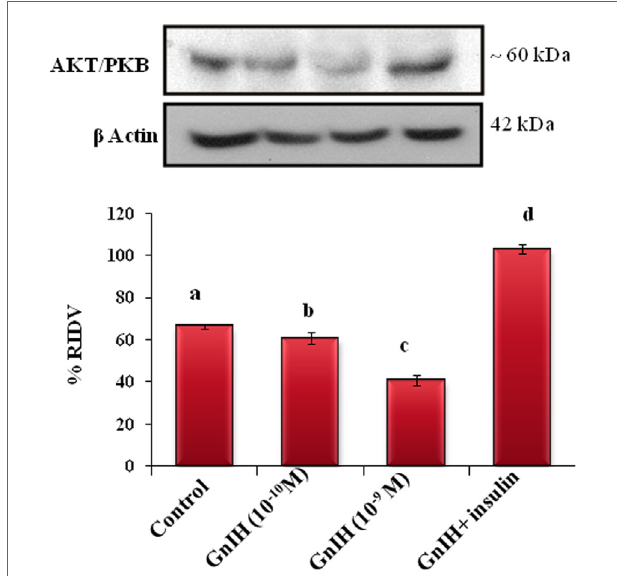
FigUre 8 | The in vitro treatment of adipose tissue with different doses (10 − 10 and 10 − 9 M/ml) of gnih alone showed a dose-dependent significant (b and c, p < 0.05) decrease in the expression of aKT/PKB protein as compared with the control . The treatment with a high dose of GnIH together with insulin showed a significant (d, p < 0.05) increase in the expression of AKT/PKB protein in the adipose tissue as compared with the only GnIH-treated group. Values are mean ± SEM.